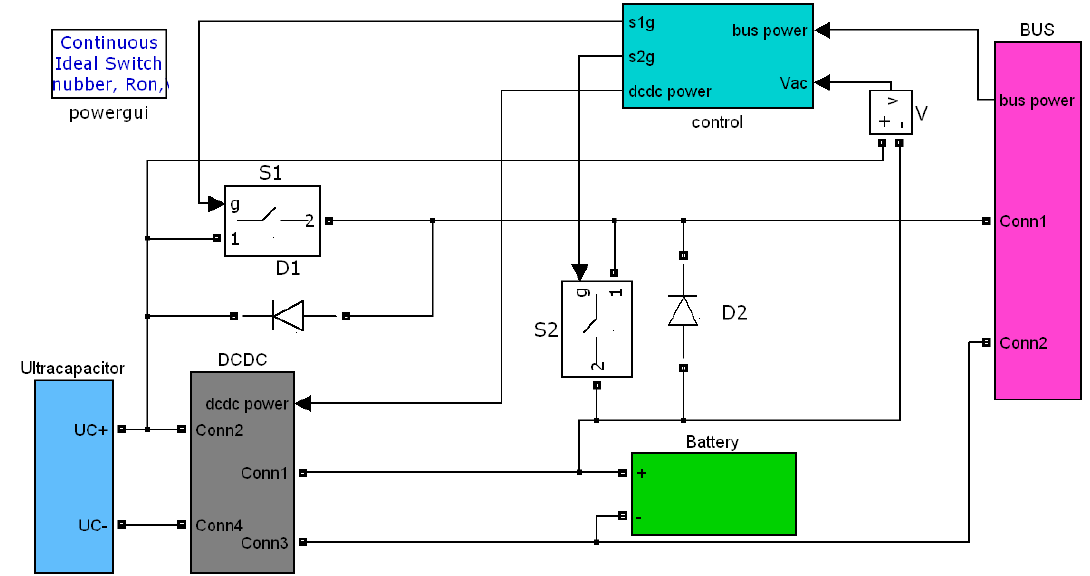
Figure 13. Simulation model in